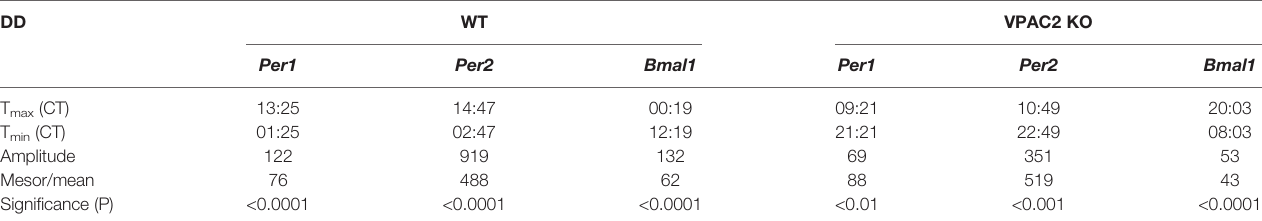
TABLE 3 | Parameters of 24-h rhythmometric analysis of Per1, Per2 and Bmal1 mRNA expression in thyroid glands of wildtype (WT) and VPAC2 receptor knockout mice (VPAC2 KO) during constant